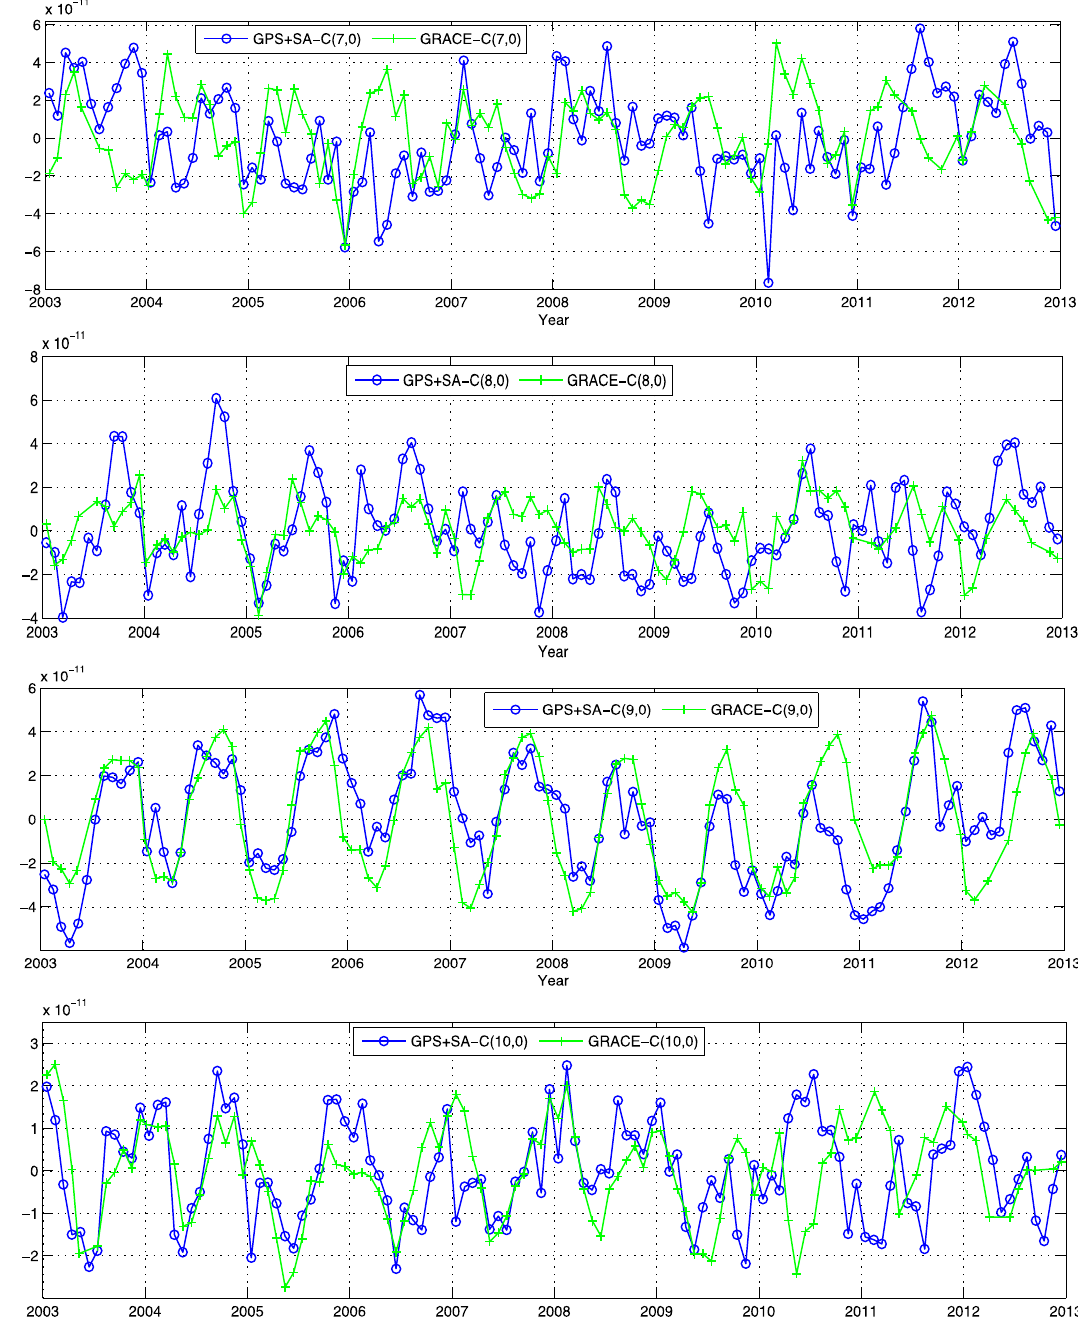
Figure 6. Low-degree zonal Stoke’s coefficients estimated from GPS+SA and GRACE. Where GPS+SA shows results by combining GPS and SA the with truncation degree at 60. GRACE results are from CSR RL05 product.